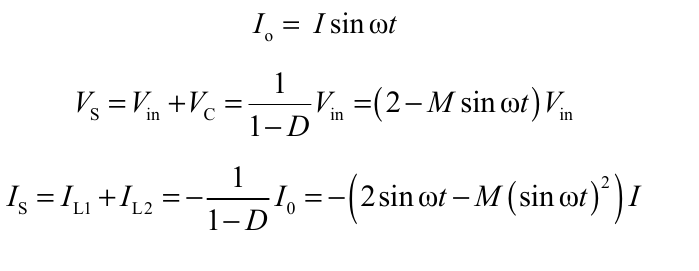
Figure 7. ( a ) Off state voltage across the switch vs . M and ω t , ( b ) On state current through the switch vs . M and ω t .